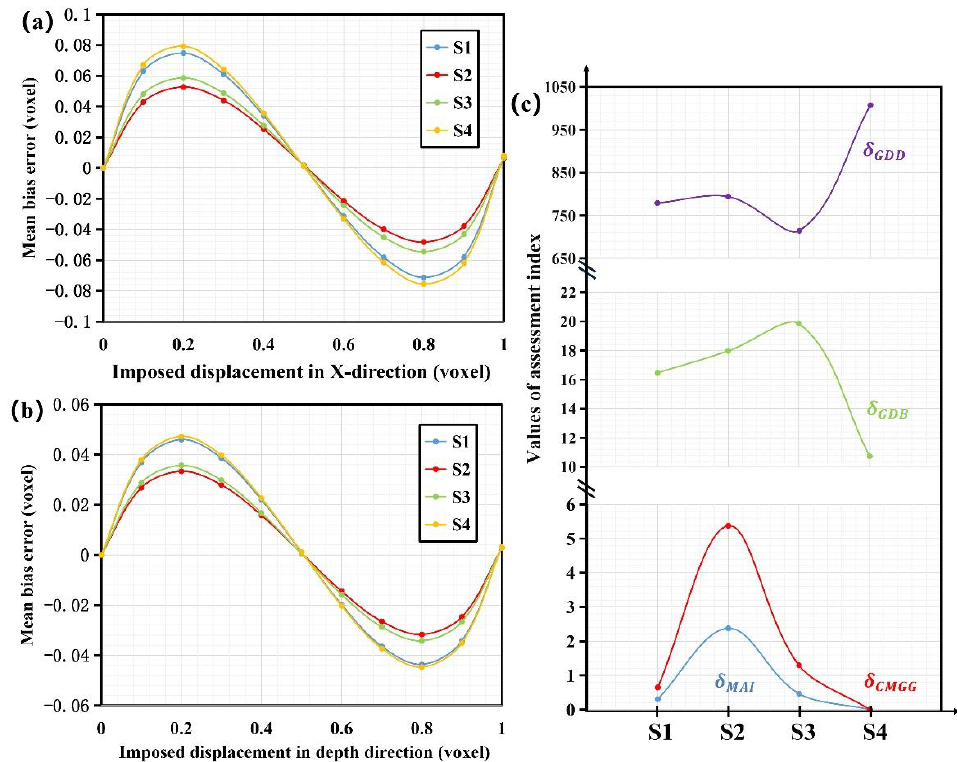
Figure 10. The verification result is based on CMGG. ( a ) Mean bias errors of imposed displacement in X direction. ( b ) Mean bias errors of imposed displacement in depth direction. ( c ) Evaluation index of OCT image with different contents of scatterers.